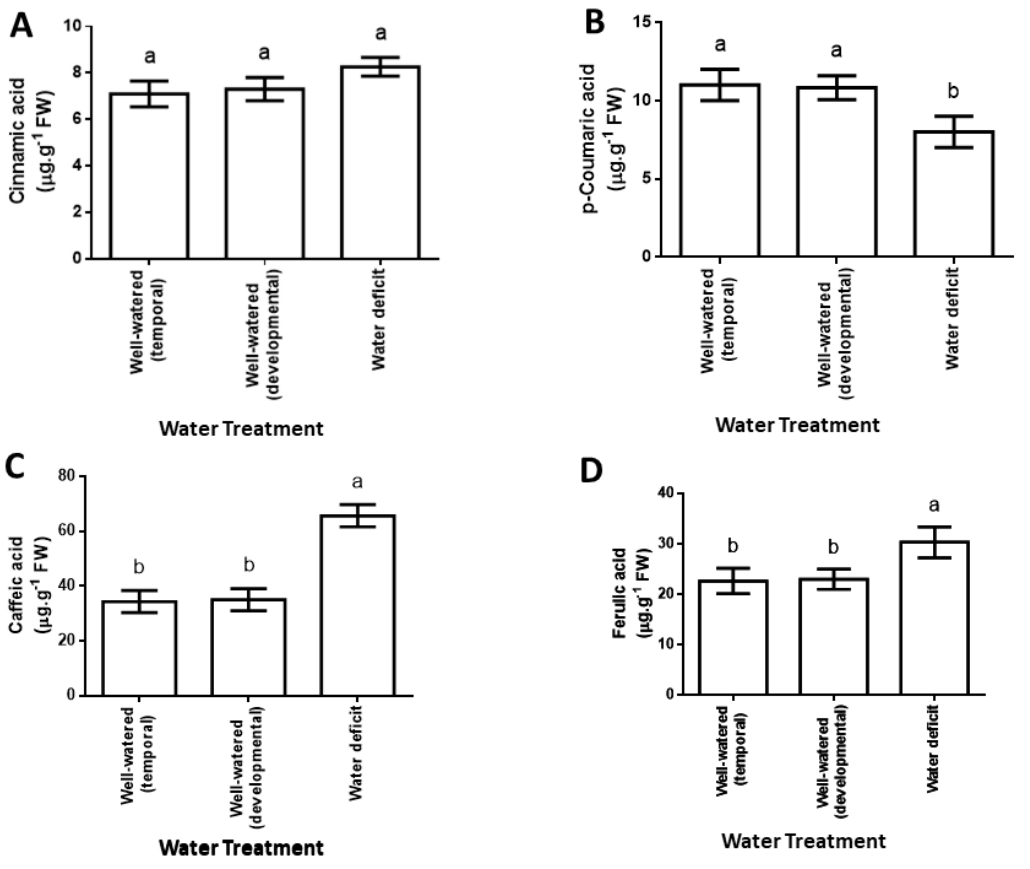
Figure 2. Effect of water deficit on cinnamic acid ( A ), p − coumaric acid ( B ), caffeic acid ( C ) and ferulic acid ( D ) contents in maize leaves. Data represent means from results obtained in extracts of the third youngest leaves from three independent experiments. FW represents fresh weight. Error bars with different letters represent significantly different means ± SD at a confidence level defined by p ≤ 0.05.